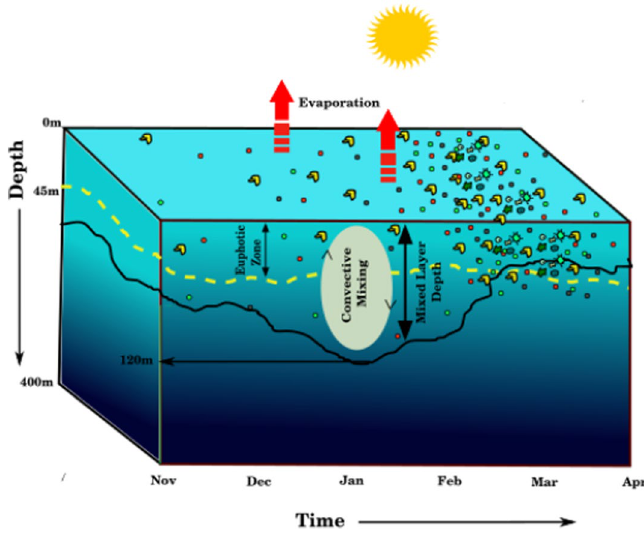
Figure 5. Schematic diagram which shows the interplay between mixed layer depth and euphotic depth on the initiation of phytoplankton